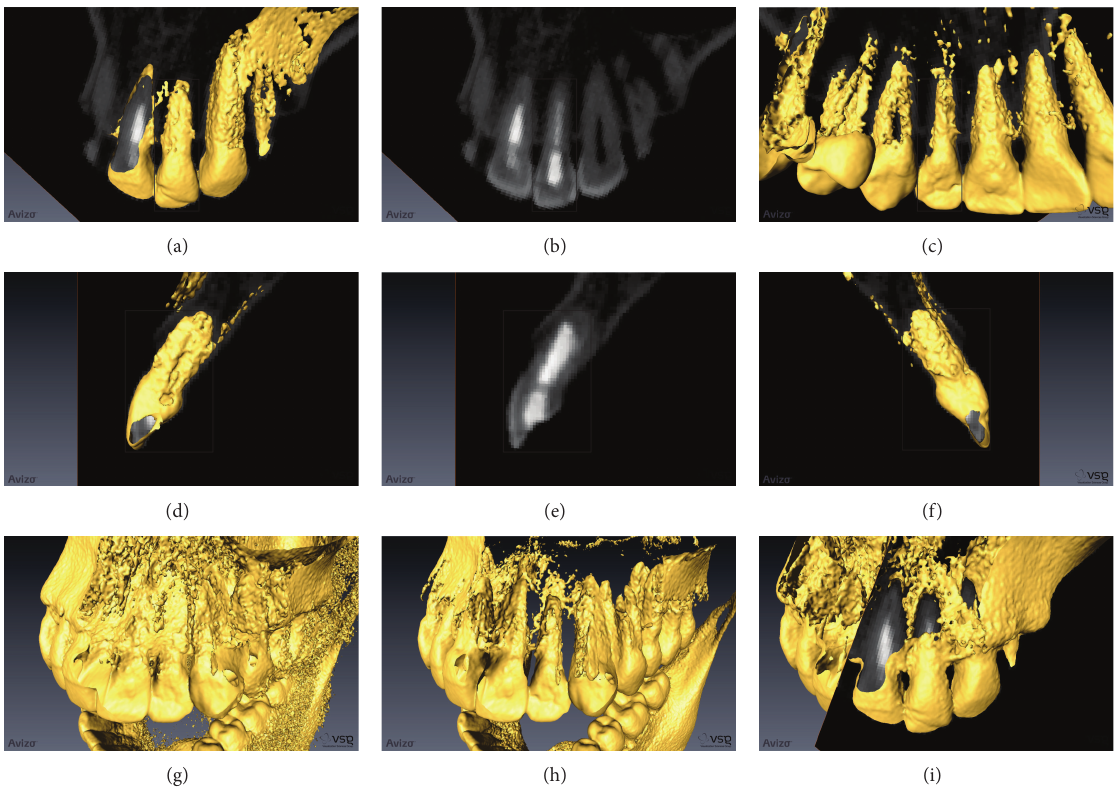
Figure 9: Cone beam computerized tomography and 3D rendering of tooth 22, visualized by the use of Avizo Fire software for Windows (Visualization Science Group, 33700 M´erignac, France). (a) 3D anterior view showing the apexification of tooth 22. (b) Anteroposterior slide in the same position of (a). (c) 3D posterior view. (d) 3D distal view. (e) Mesiodistal slide in the same position of (d). (f) Mesial view. (g) Frontal slide in the middle of tooth 22 showing a complete formation of periapical bone around apex. (h) The same view from (g), but with lower bone density performed by the software. It can be observed that the periapical bone was maintained. (i) Diagonal slides mixing 2D and 3D views, where the complete apexification and formation of periapical bone can also be